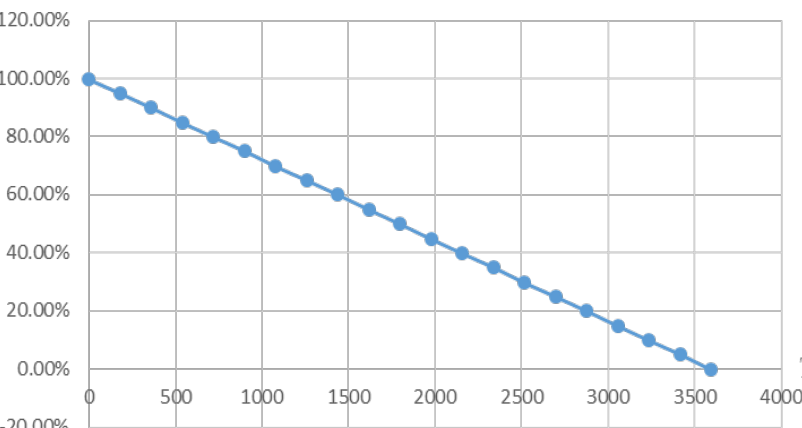
Figure 11. The relationship between the ESR and T . Table 3. Electric energy ( E ph ), annual electric energy ( E py ), energy-saving rate (ESR), annual elec- tricity consumption ( D py ), annual cost ( M py ) and annual carbon emission reduction ( C py ) values of each fan with different average hourly start-up ( T ) values.